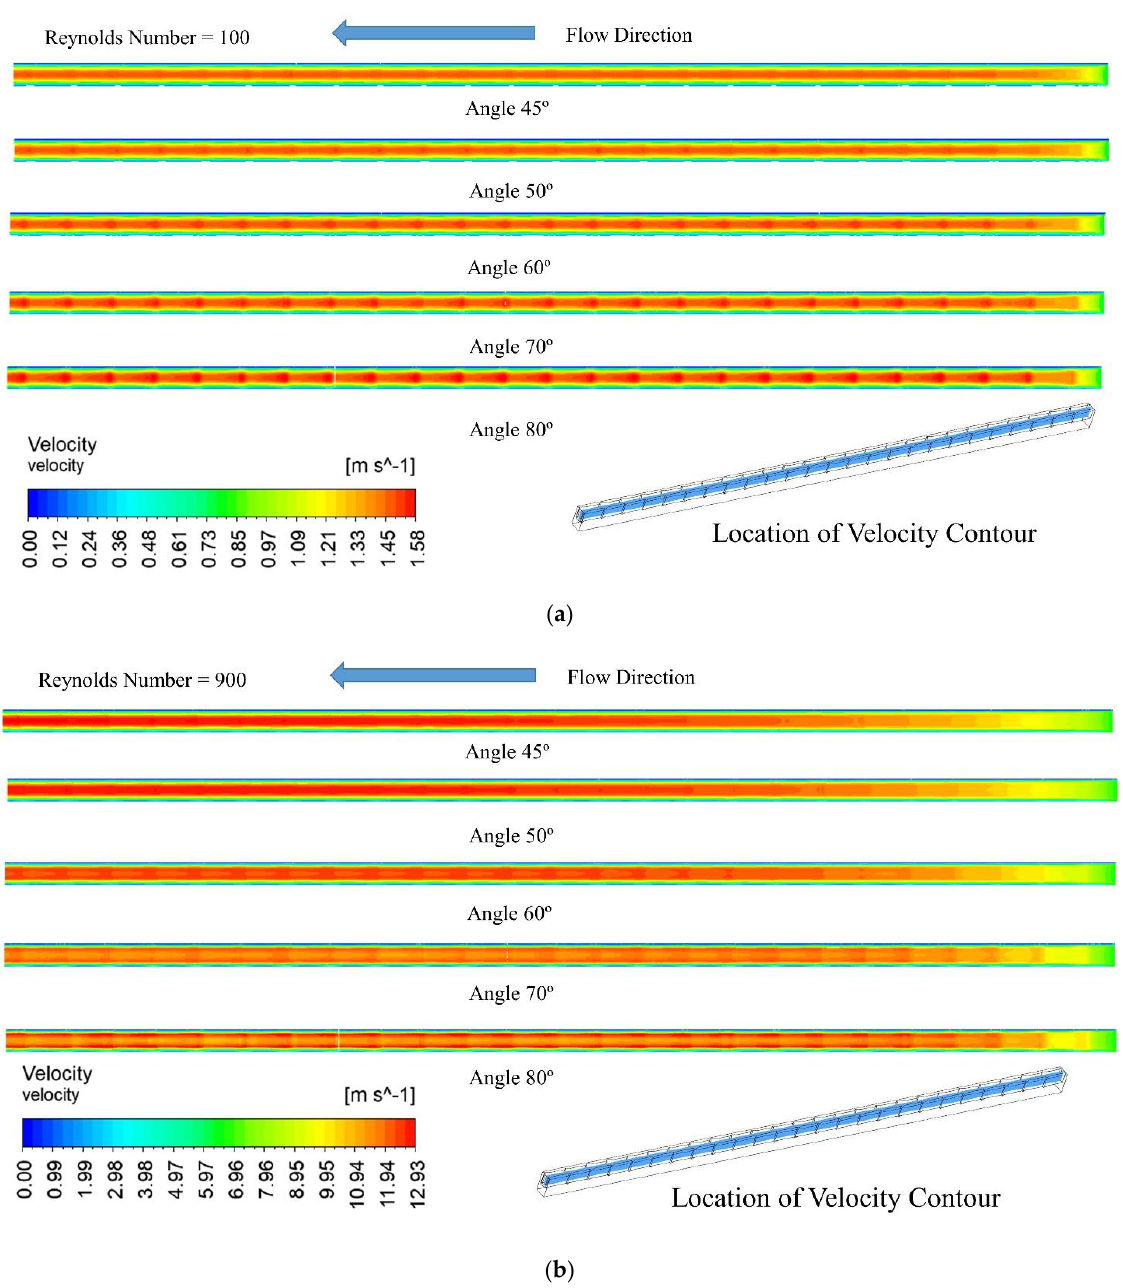
Figure 5. Distribution of velocity in microchannel’s fluid domain at ( a ) Re = 100 and ( b ) Re = 900 at various angles.